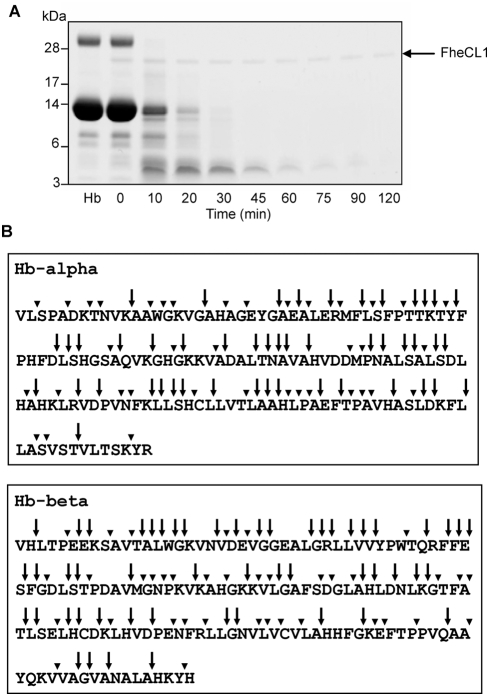
Characterisation of hydrolytic activity of FheCL1 on Hb.(A) Progress of digestion of Hb by recombinant FheCL1. Purified haemoglobin (Hb, lane 1) was digested by FheCL1 in 0.1 M sodium acetate buffer, pH 4.0, containing 1 mM GSH and 1 mM EDTA at 37°C. Reactions were stopped at time 0 and at various time-points (indicated on x axis) by the addition of the cysteine protease inhibitor E-64 and analysed on 4–12% Bis-Tris NuPage gels. The arrow indicates the position of FheCL1 (25 kDa) that was not degraded in the reaction. Molecular mass markers are shown on the left. (B) Map of Hb α- and β-chains indicating sites of FheCL1 cleavage the substrates. Cleavage sites within Hb present in 10 min reactions (arrows) compared to cleavages that occur with longer incubation times (120 min, arrowheads) as determined by nanoLc-MS/MS.